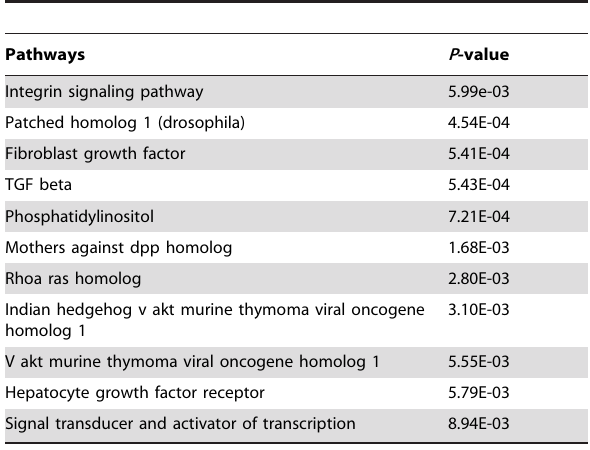
Table 5. Network pathway analysis of differentially expressed genes by Genomatix.